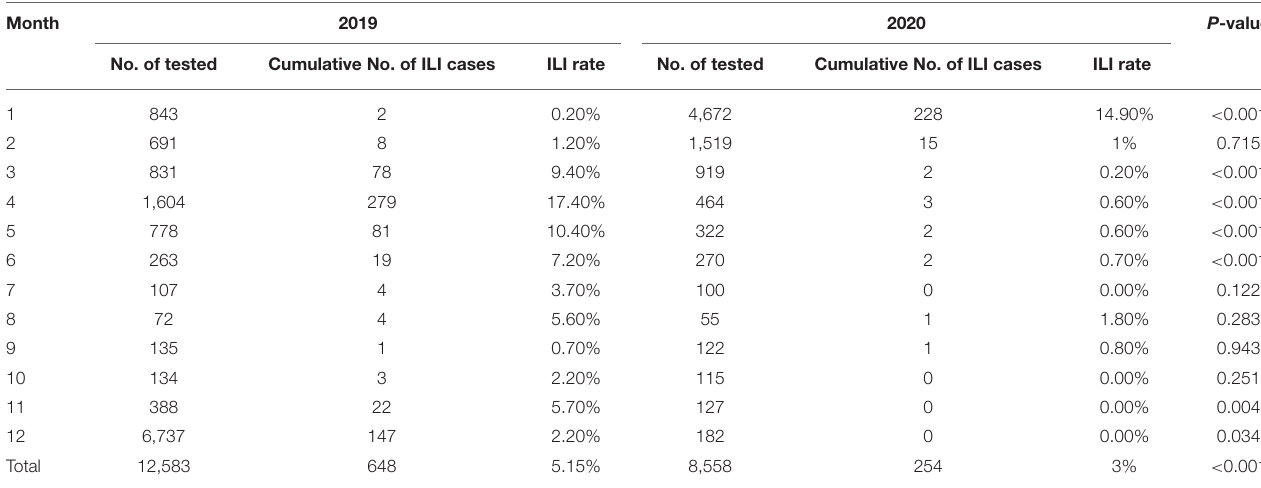
TABLE 2 | Progress of influenza B-like illness rate in 2019 and